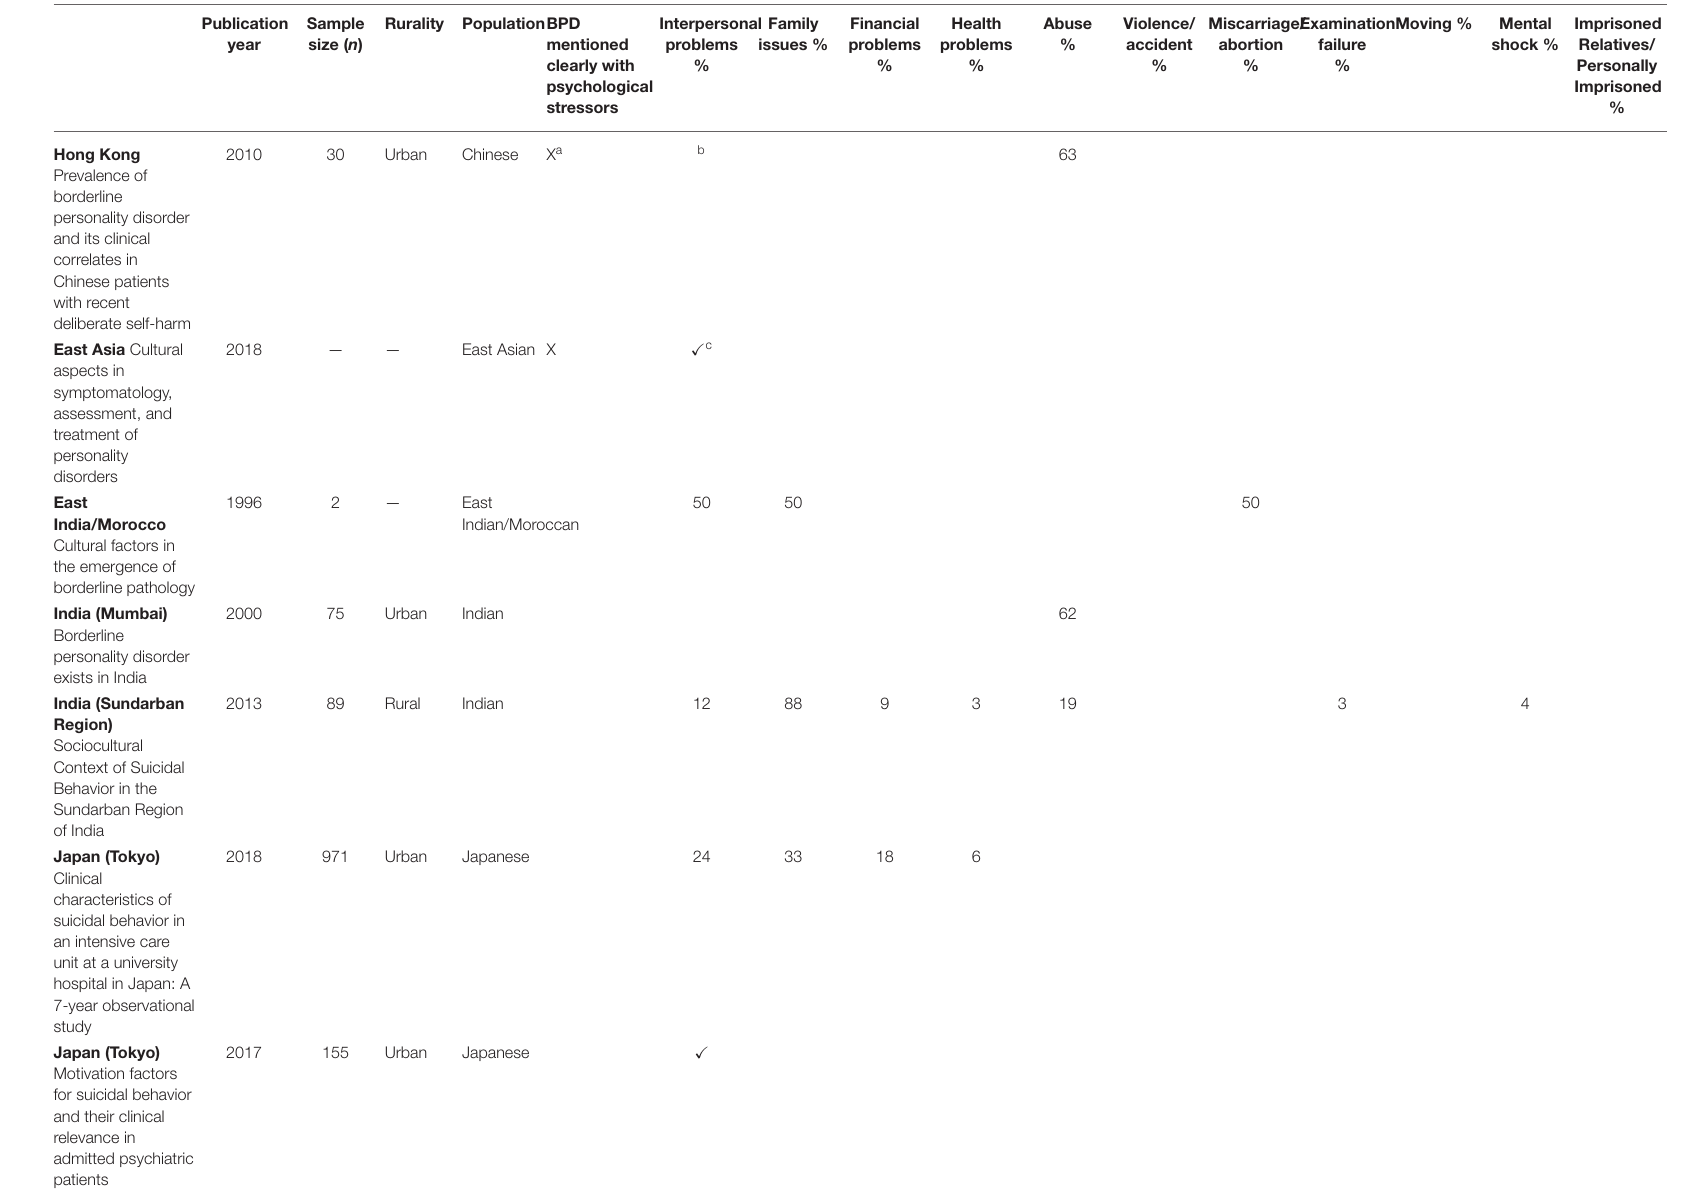
TABLE 4 | Psychological stressors by study based on 12 BPD